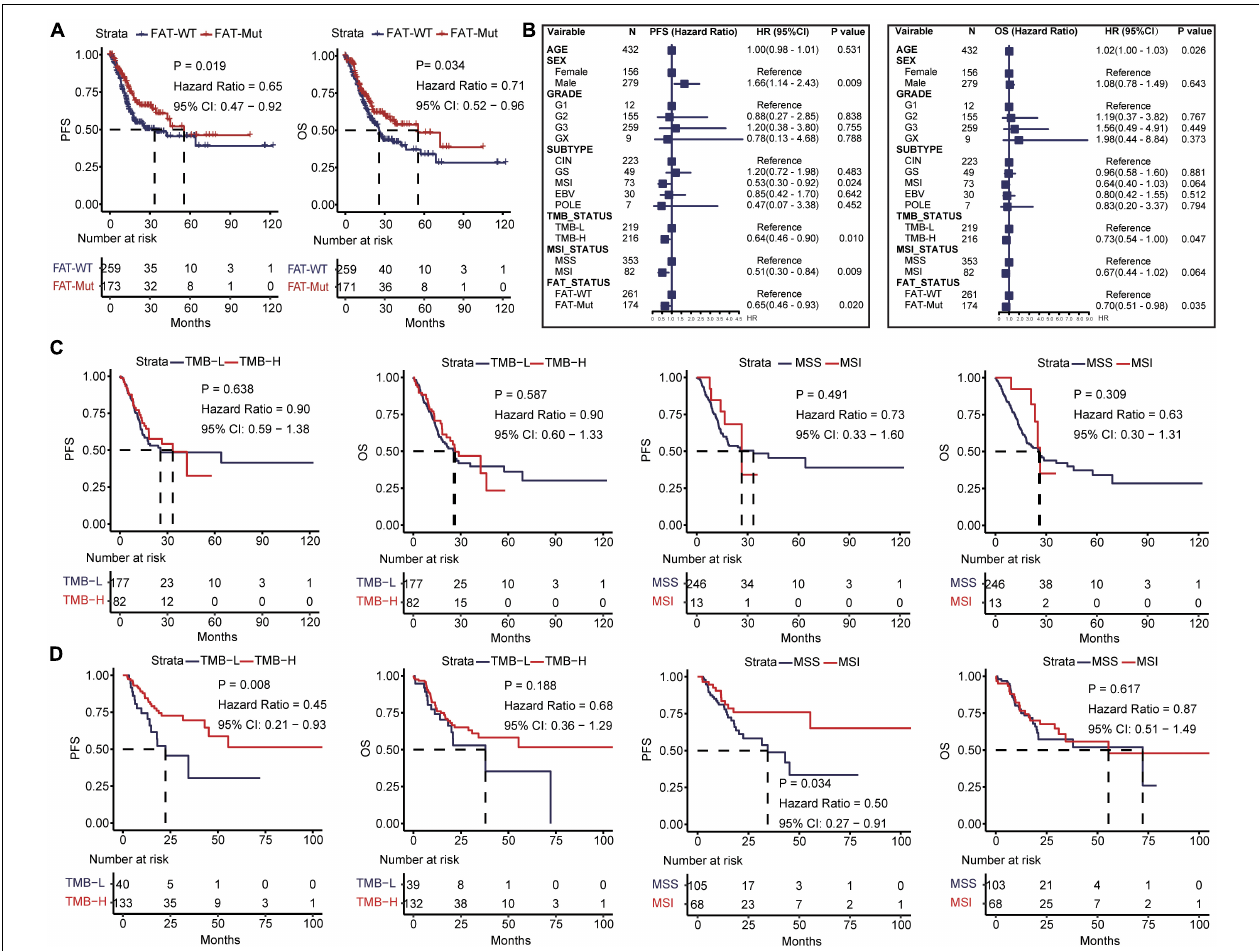
FIGURE 2 | Impacts of FAT mutations on prognosis and clinical characteristics. (A) Kaplan-Meier analysis of PFS and OS in STAD patients with FAT mutations. (B) Univariate Cox regression analysis of age, gender, grade, subtype, TMB, MSI status, and FAT mutations. (C) Kaplan-Meier analysis of PFS and OS of TMB (the median TMB of all patients was 117 as cutoff) and MSI in FAT-WT patients. TMB, tumor mutational burden; MSS, microsatellite-stable; MSI, microsatellite instability. (D) Kaplan-Meier analysis of PFS and OS of TMB (the median TMB of all patients was 117 as cutoff) and MSI in FAT-Mut